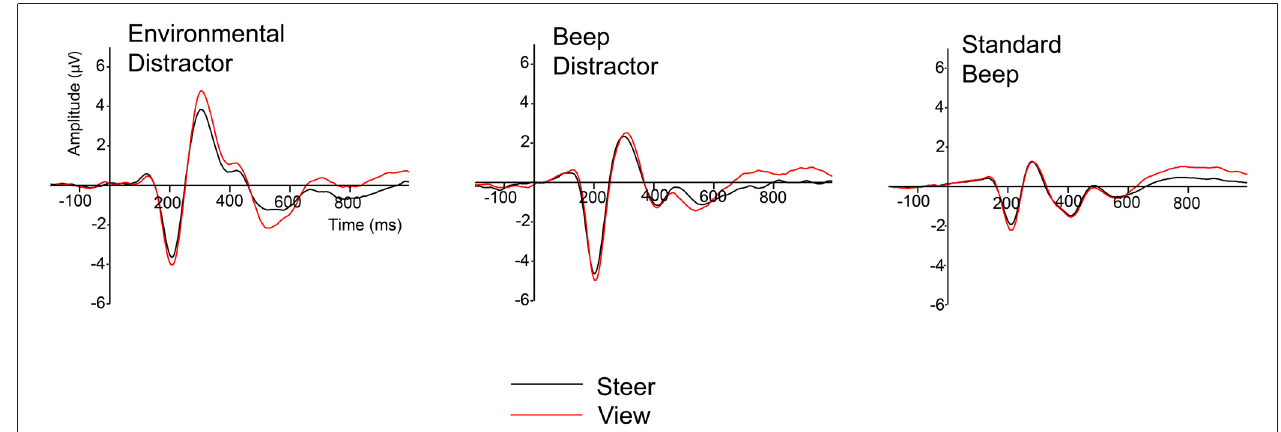
FIGURE 4 | Grand averaged waveforms after the stimulus presentation of the environmental distractors, beep distractors and standard beeps for the viewing (red) and steering (black) trials.